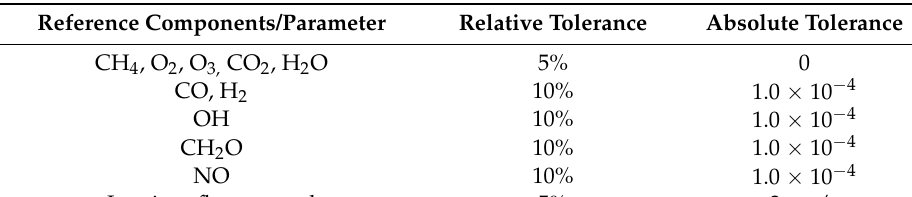
Table 2. Tolerances of the reference components and parameter.